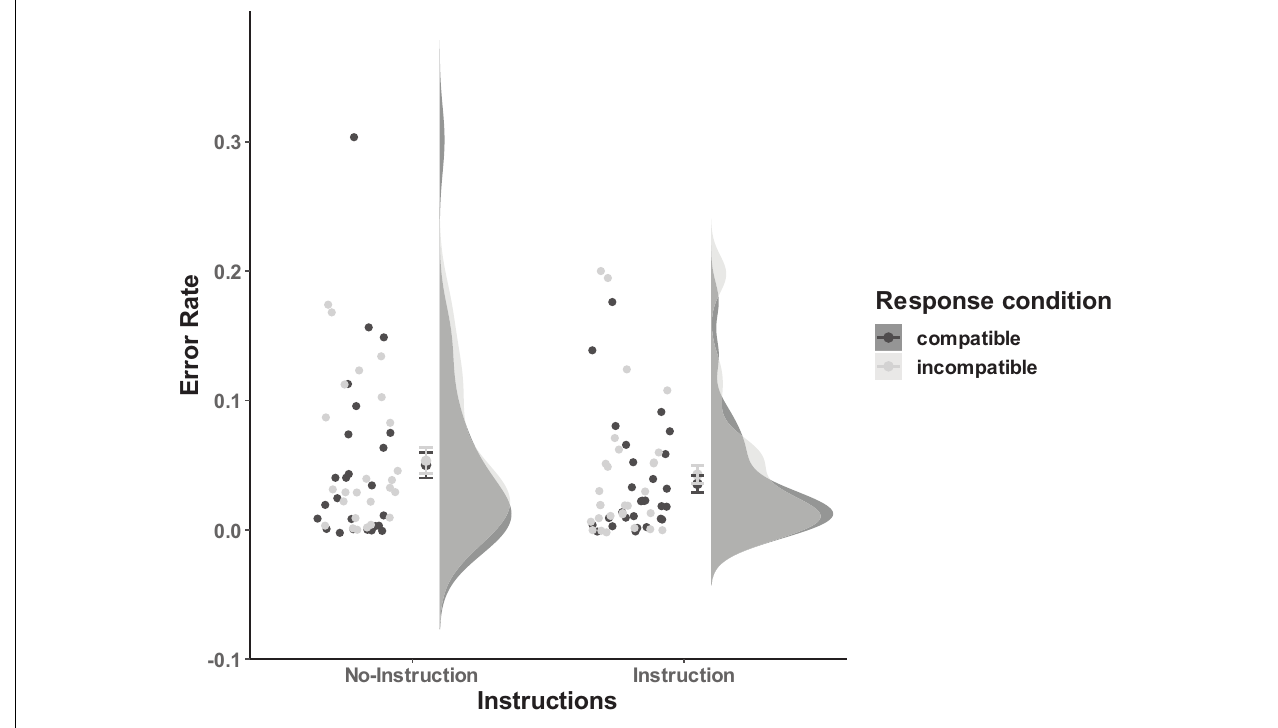
FIGURE 7 | Distribution of error rates of Experiment 3a. The compatible and incompatible trials are defined depending on the Response-Outcome mapping in the acquisition phase. Error bars represent the 95% confidence intervals.